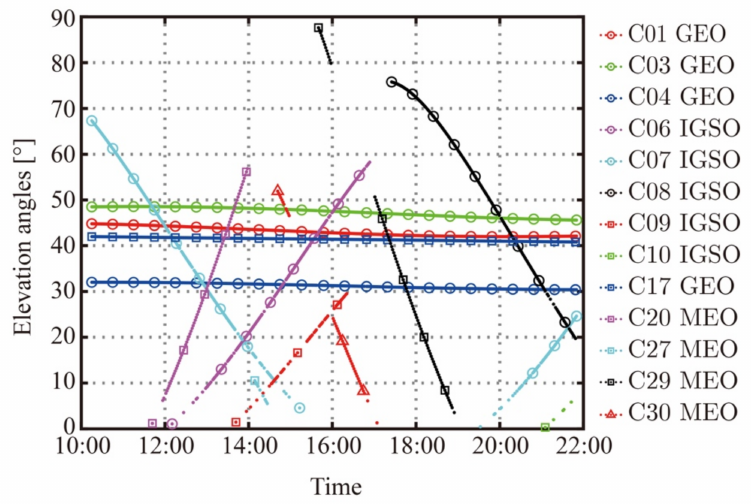
Figure 10. Scatter plot of the elevation angles obtained using the precise ephemeris of the BDS satellites.